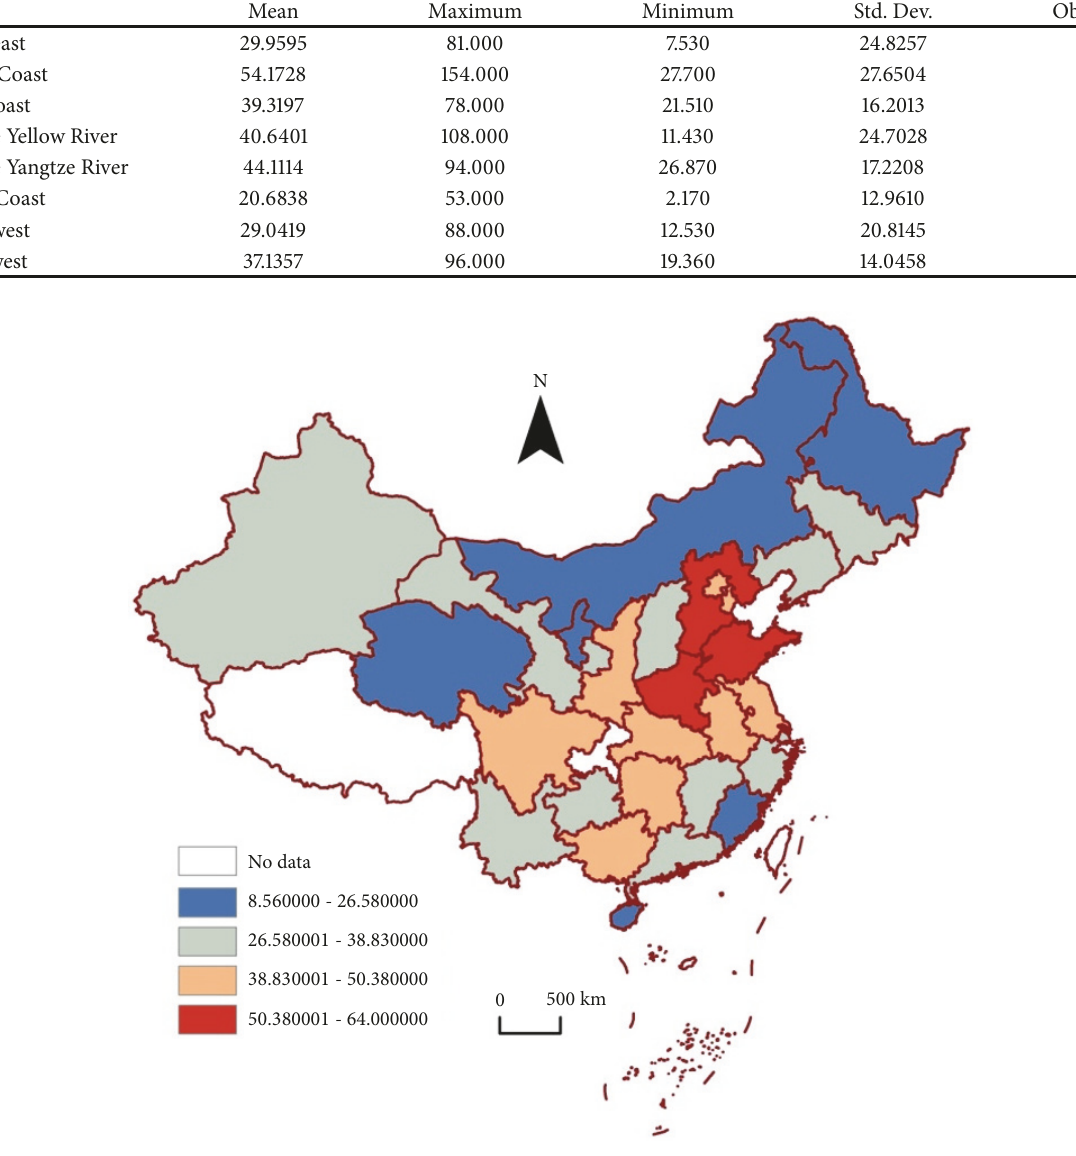
Figure 2: Spatial distribution of PM 2.5 average value in